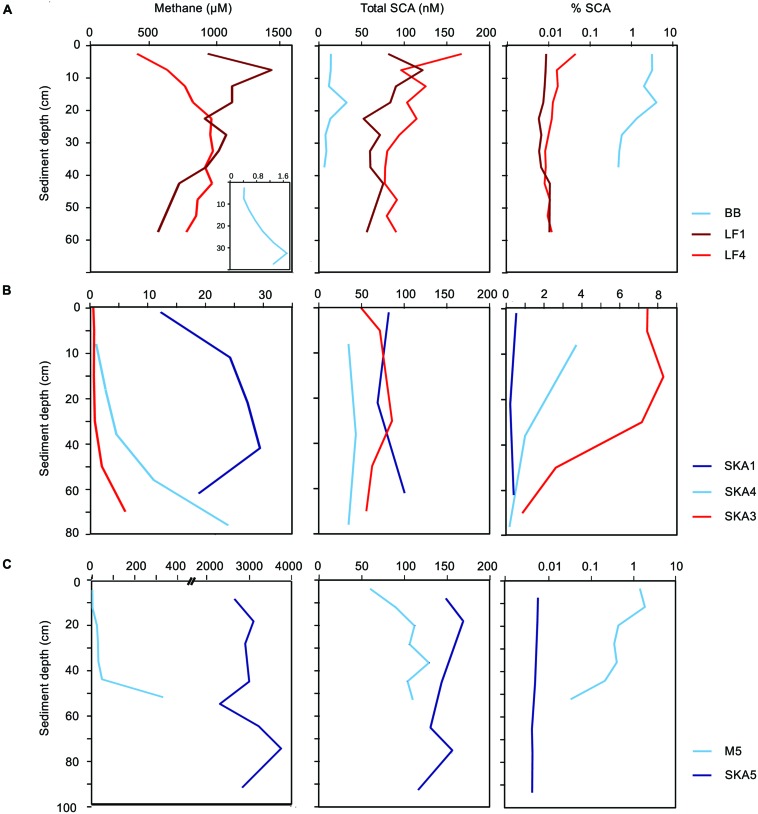
Methane, total short-chain alkane (SCA) concentrations and their abundance relative to methane in seepage and pristine sediments. (A) Limfjorden, (B) Skagerrak, (C) Aarhus Bay (M5) and Lille Belt (SKA5). Red lines: seepage sediments, blue lines: pristine sediments. Please note that methane concentrations and % SCA are displayed on different scales dependent on the sampling site, while total SCA concentrations are displayed on the same scales.